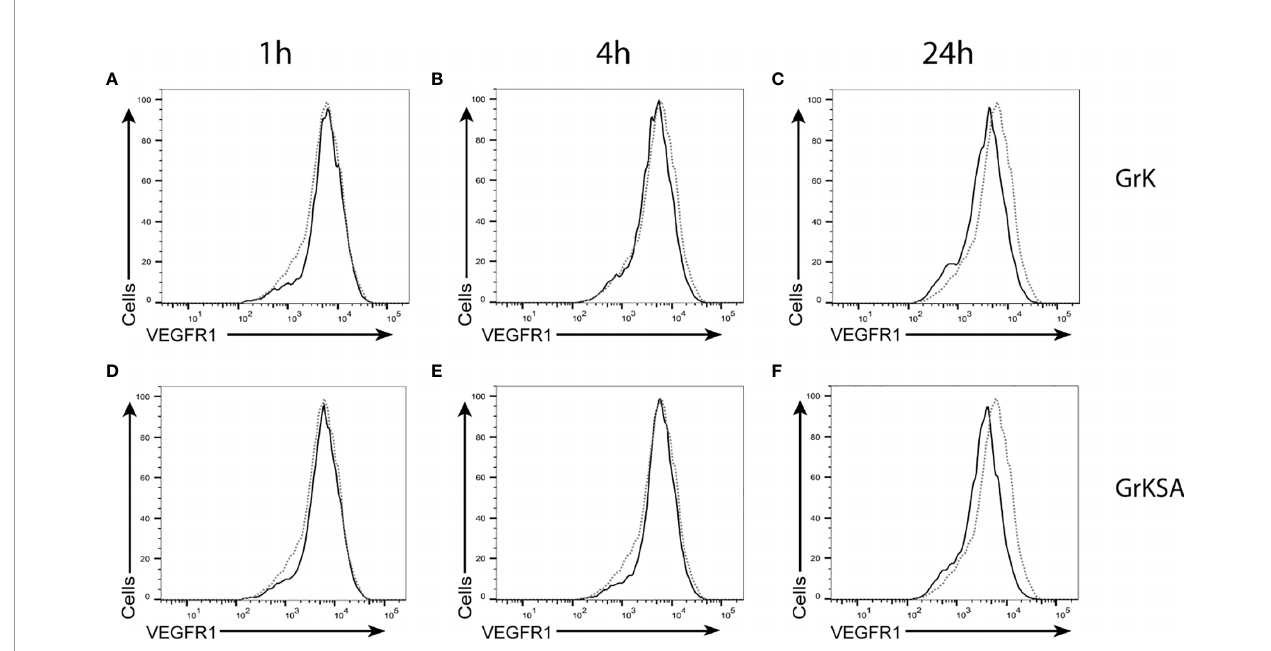
FIGURE 3 | GrK does not cleave membrane-bound VEGFR1. HUVECs were treated with 500nM GrK or GrKSA and the amount of membrane-bound VEGFR1 was measured by fl ow cytometry. Incubation for (A) 1h, (B) 4h, (C) 24h of GrK and (D) 1h, (E) 4h, (F) 24h of GrKSA is shown. X-axes show anti-VEGFR1 antibody (logarithm of fl uorescence), Y-axes depict the cell count. The signal for untreated cells is depicted in dotted line. The signal for GrK- or GrKSA-treated cells is depicted in solid black line. Figures are representative experiments